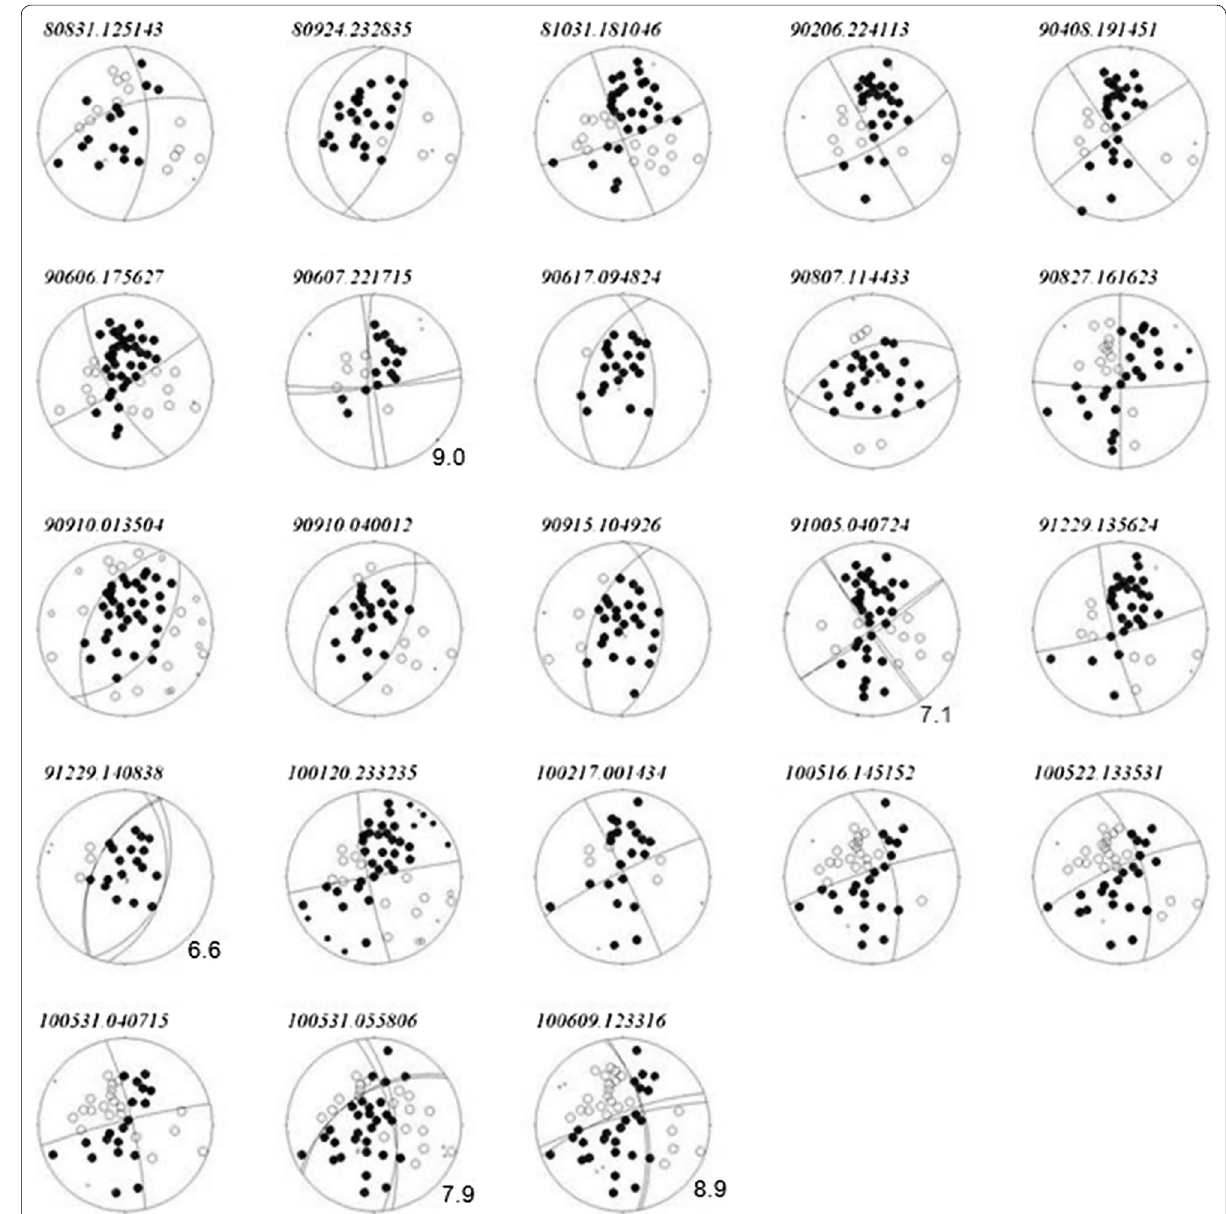
Fig. 4 Examples of estimated focal mechanisms in the upper hemisphere of the events in a subregion with dimensions of 1 km per grid point ( x 9, y 6, z 3). Focal mechanisms were determined using the program of Maeda (1992), in which all fault plane solutions with the least = = = − inconsistent polarities were extracted by a grid search with a spacing of about 8° in azimuth and dip directions of the B -axis on the focal sphere. Numerals shown to the lower right side of the focal mechanisms with plural solutions represent errors in focal mechanisms estimated from the larg- est differences between multiple numeric